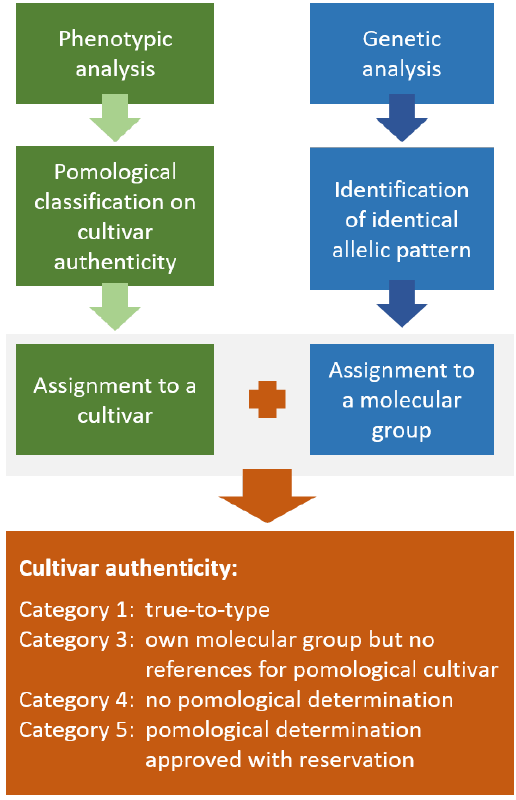
Figure 6. Workflow for the assessment of cultivar authenticity in sweet cherries based on phenotypic and genetic data (category 2 is missing because it is only used for categorizing sour cherries).